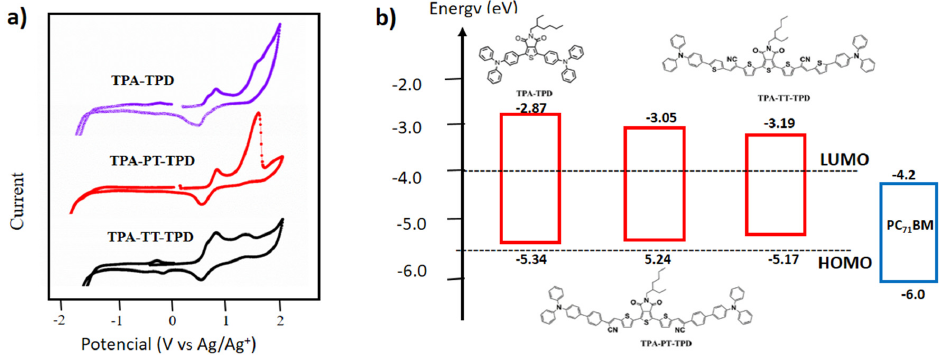
Figure 3. ( a ) Cyclic voltammogram (CV) (50 mV s − 1 ) and ( b ) HOMO-LUMO electrochemical energy-level diagrams of TPA-TPD , TPA-PT-TPD and TPA-TT-TPD .